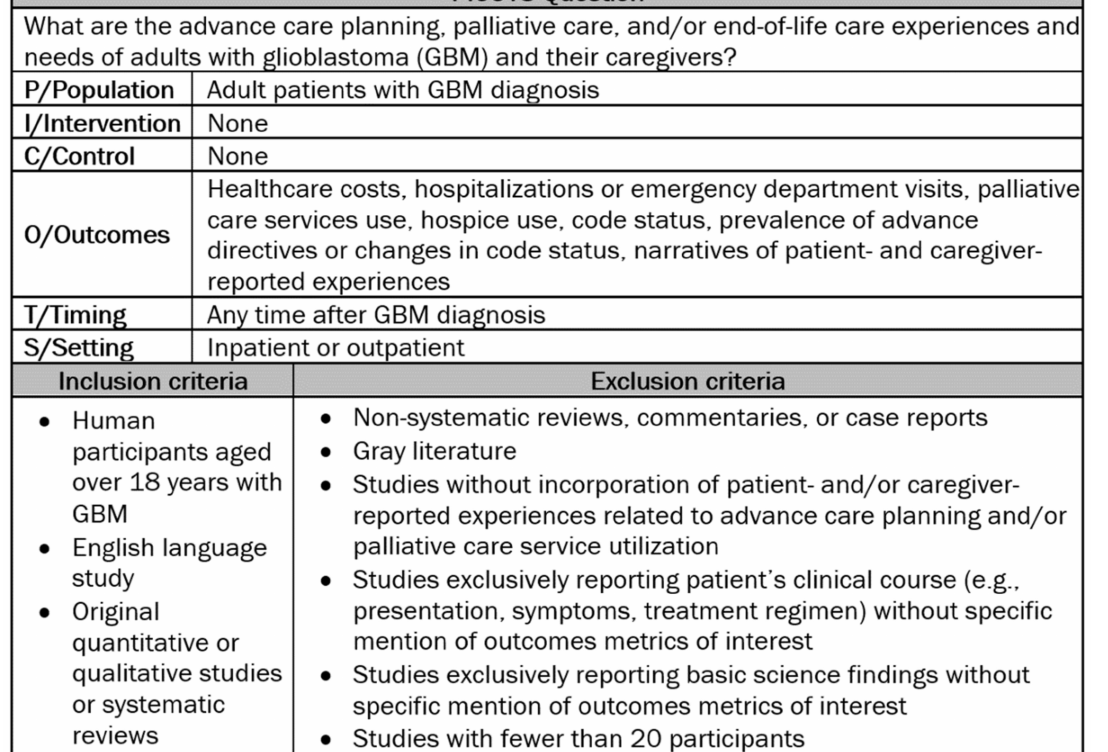
Figure 1. Population, intervention, comparison, outcomes, timing, and study design (PICOTS) question, inclusion criteria, and exclusion